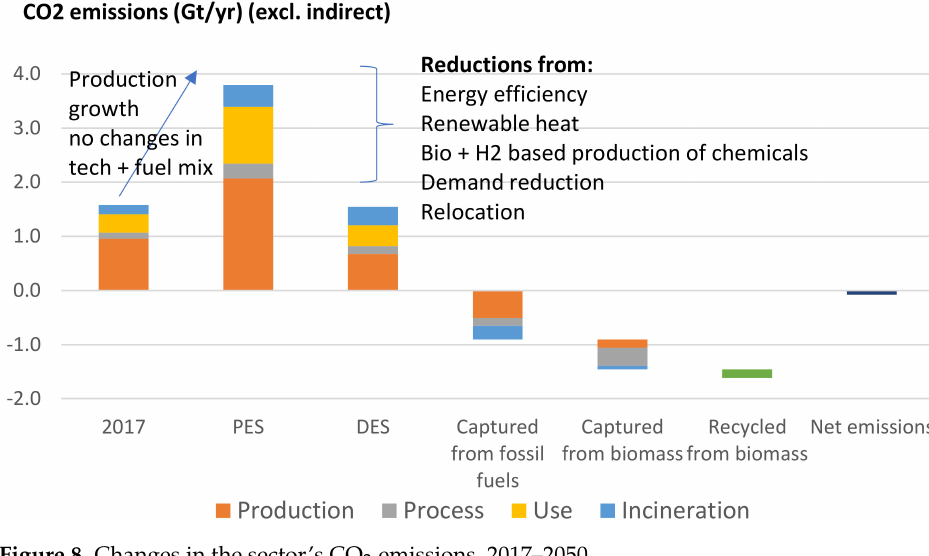
Figure 8. Changes in the sector’s CO 2 emissions, 2017–2050.